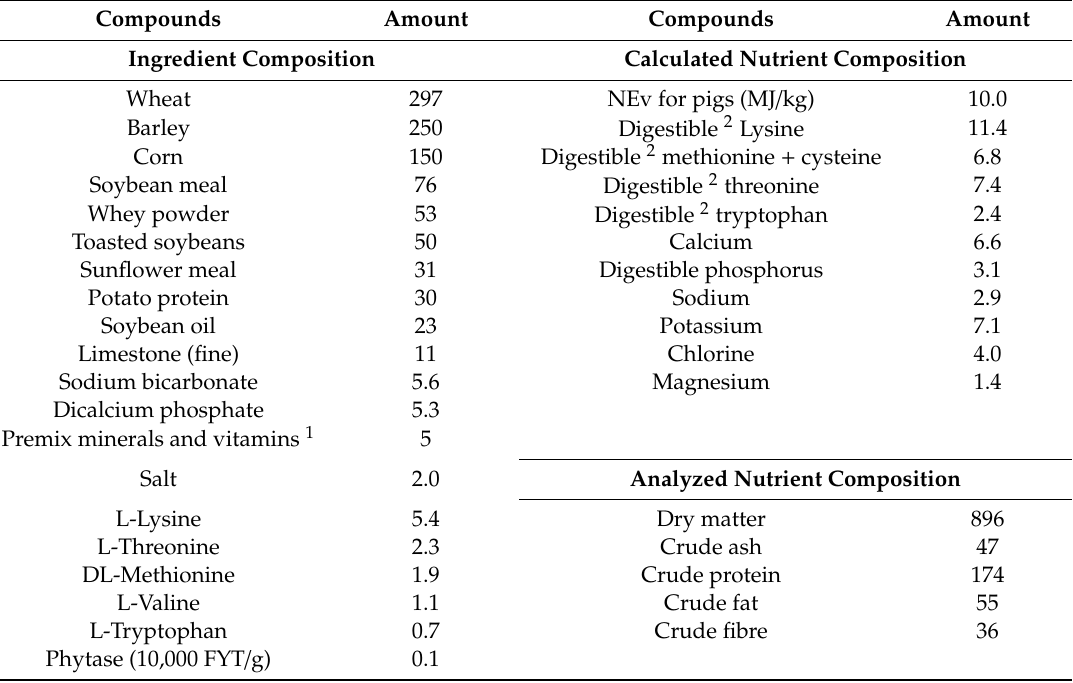
Table 1. Ingredient and analyzed nutrient composition of the basal diet (g / kg as fed). Compounds Amount